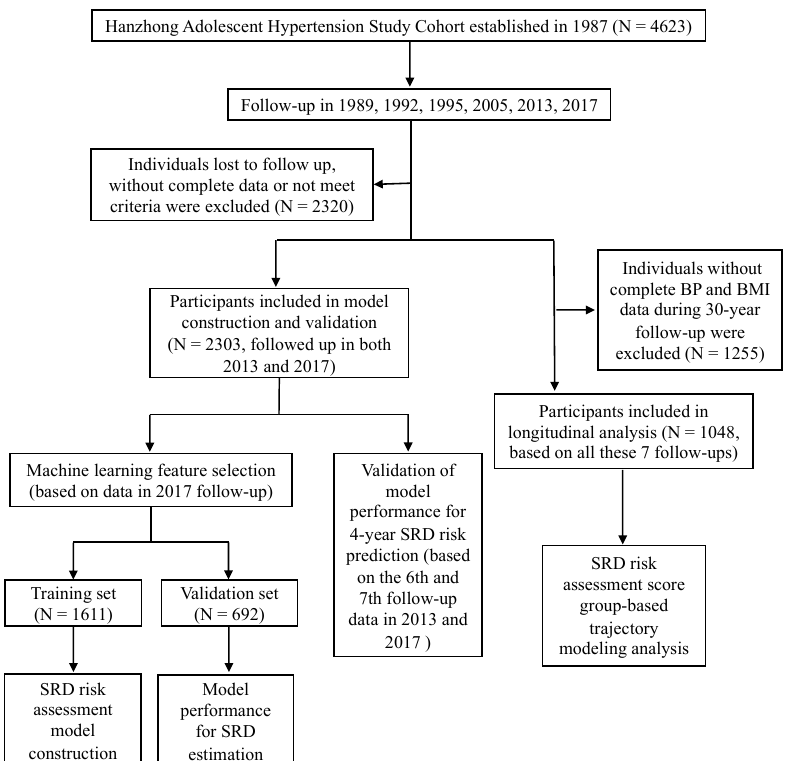
Figure 1. Flow chart of research design. Table 1. Characteristics of the participants in the training and internal validation sets.